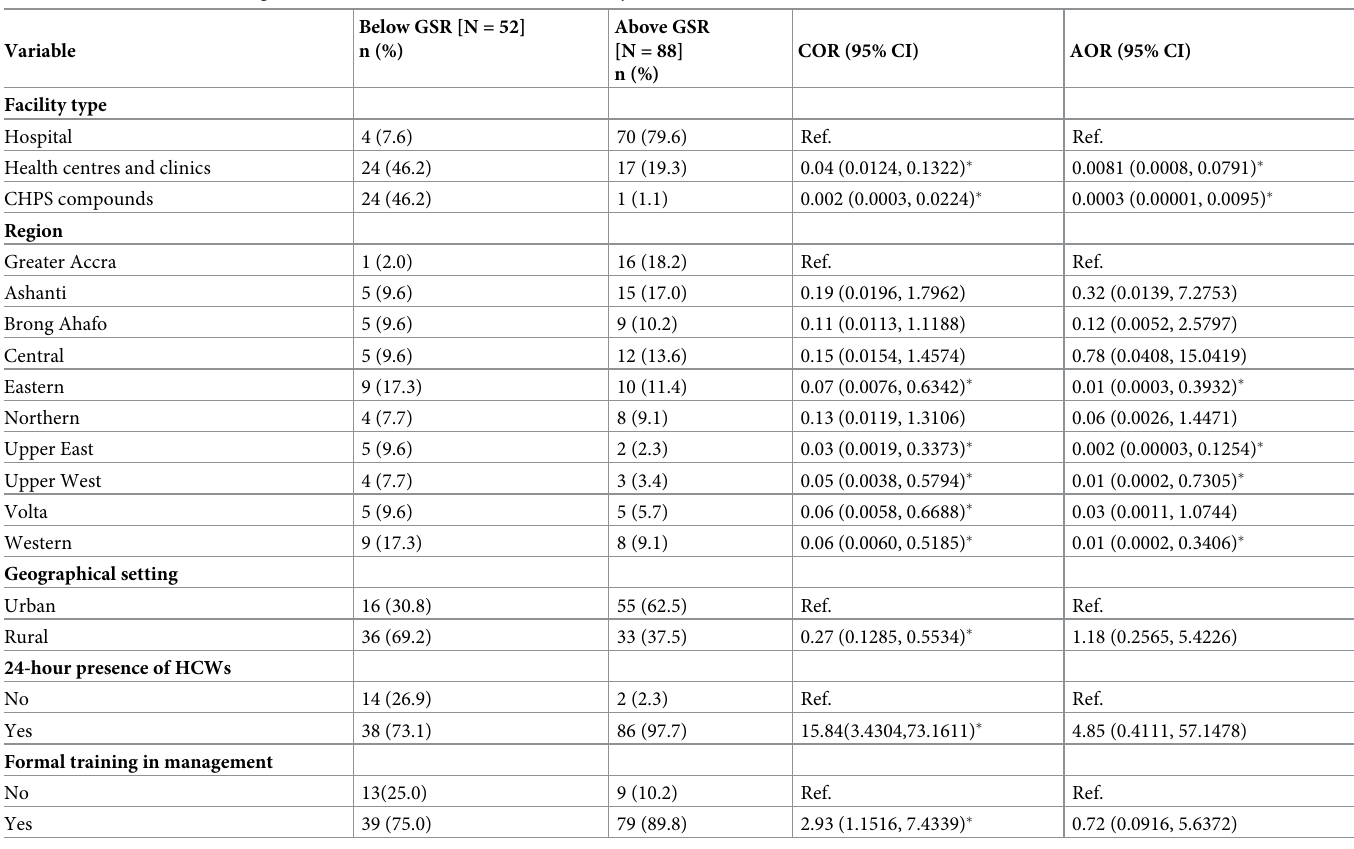
Table 4. Associations between general service readiness and selected facility-related